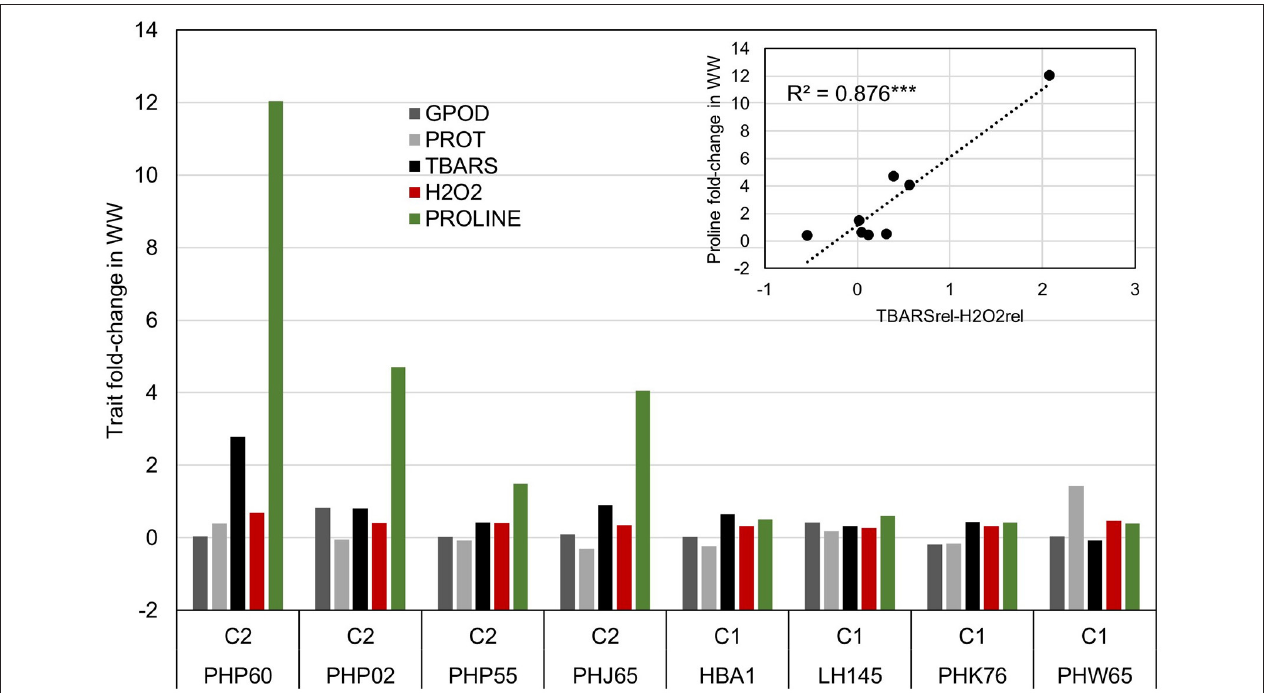
FIGURE 4 | Analysis of trait fold-change values in inbred representatives surrounding the centroids of clusters in Figure 3 and the most extreme phenotypes in cluster one (PHW65) and two (PHP60). Linear model shows the relationship between the difference in trait fold-change values of TBARS and H 2 O 2 and Proline accumulation in WW treatment in eight selected